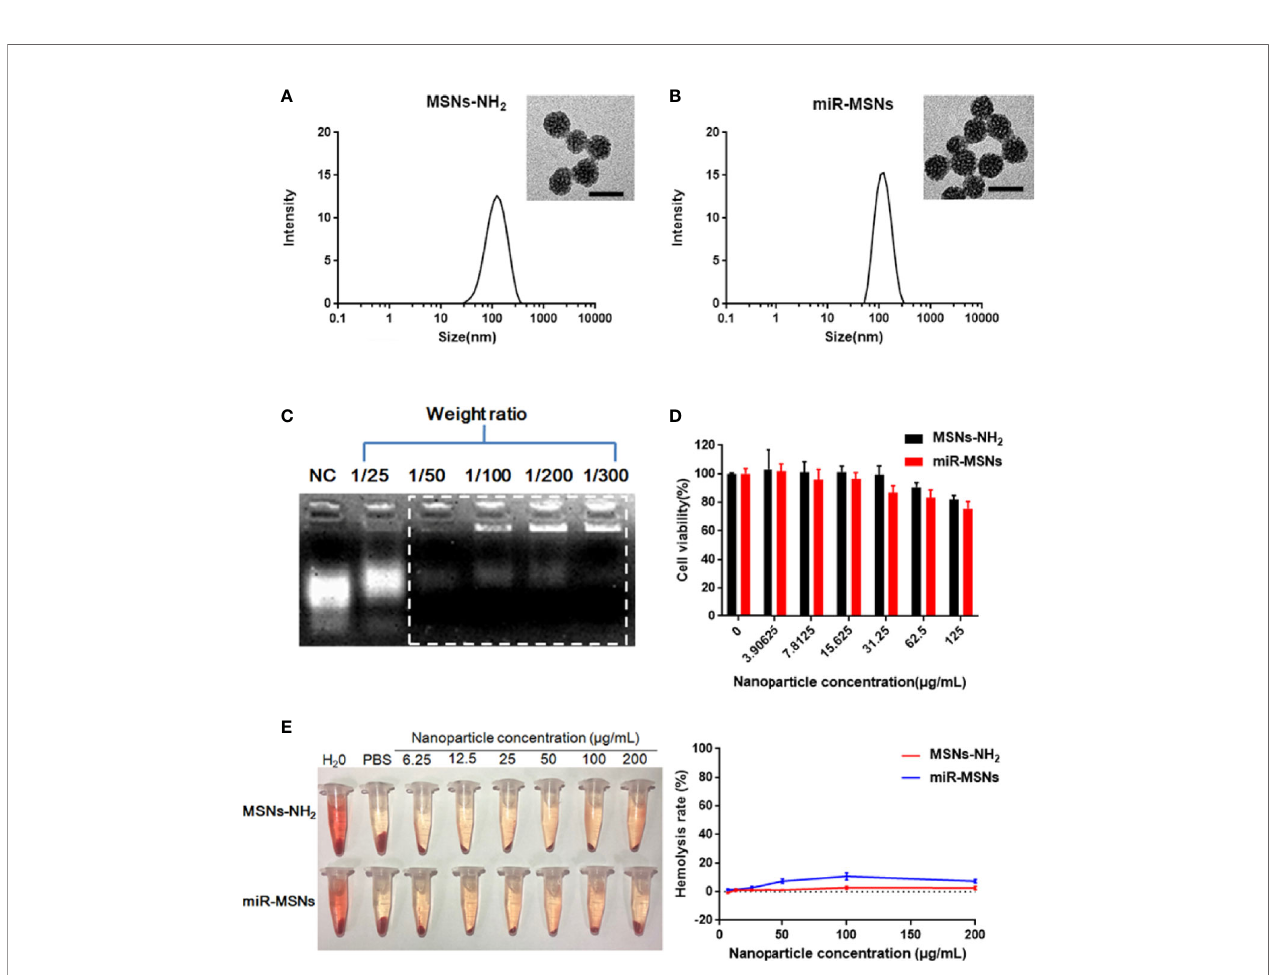
FIGURE 1 | (A) Hydrodynamic diameter of MSNs-NH 2 and the corresponding TEM image. Scale bar = 50 nm. (B) Hydrodynamic diameter of miR-MSNs and the corresponding TEM image. Scale bar = 50 nm. (C) Agarose gel electrophoresis of miR-33 antagomirs bonded with MSNs-NH 2 at different weight ratios. (D) Cytotoxicity of MSNs-NH 2 and miR-MSNs via CCK-8 assays. n=3. (E) Hemolysis assay and images of RBCs incubated with MSNs-NH 2 and miR-MSNs. n=3.